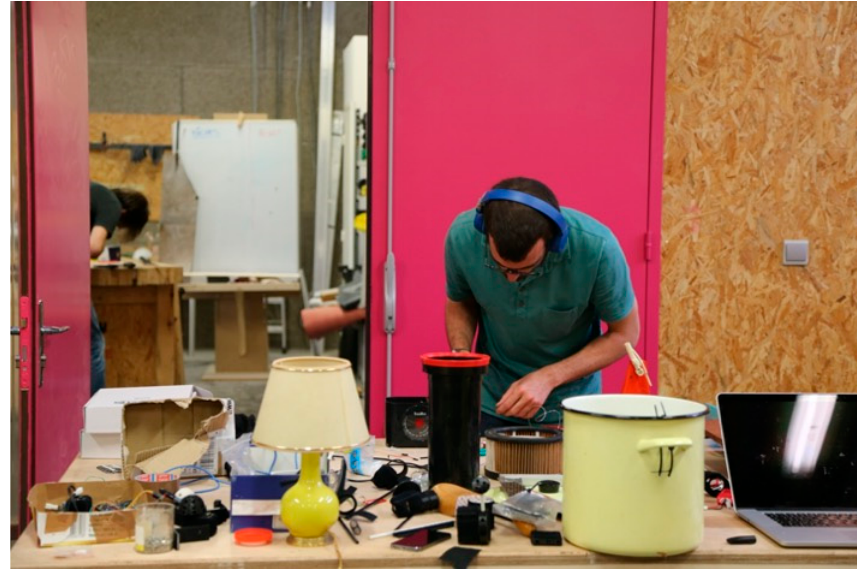
Figure 4. GOR Artist Residency at Bel Ordinaire, Pau, France, 2017.